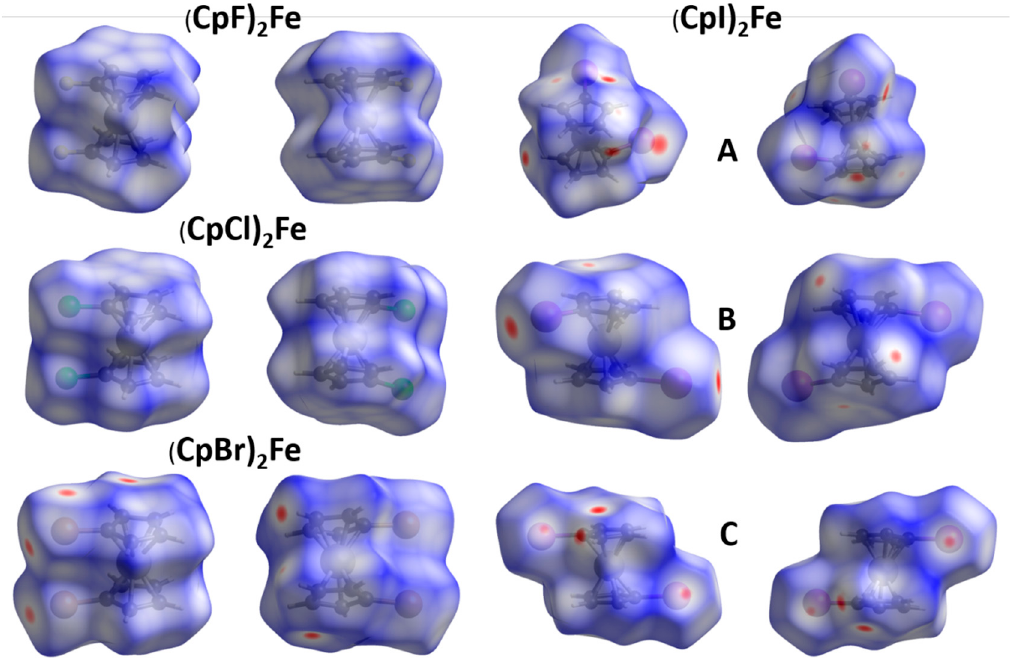
Figure 3. Hirshfeld surfaces for (CpX) 2 Fe compounds (X = F, Cl, Br, I (three isomers)).